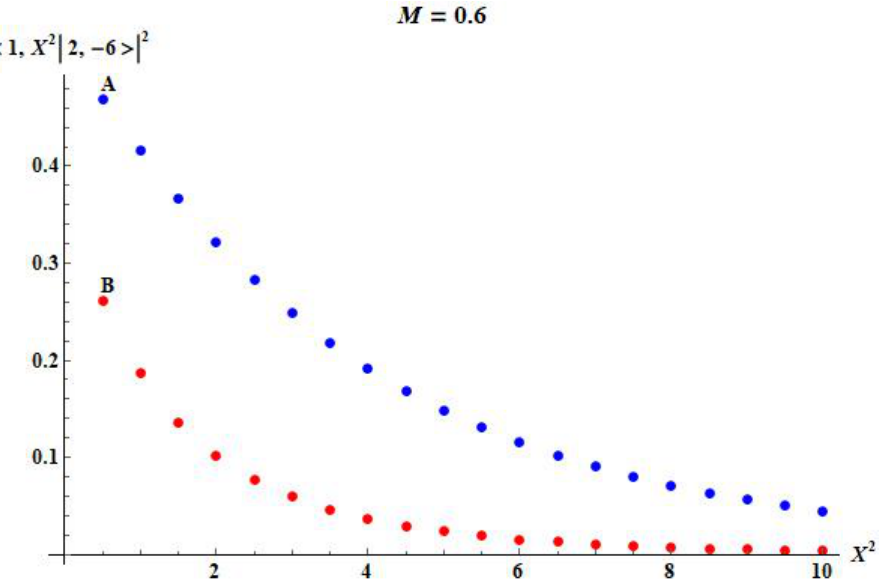
Figure 3. II → I (curve B) vs. I → II (curve A) transition